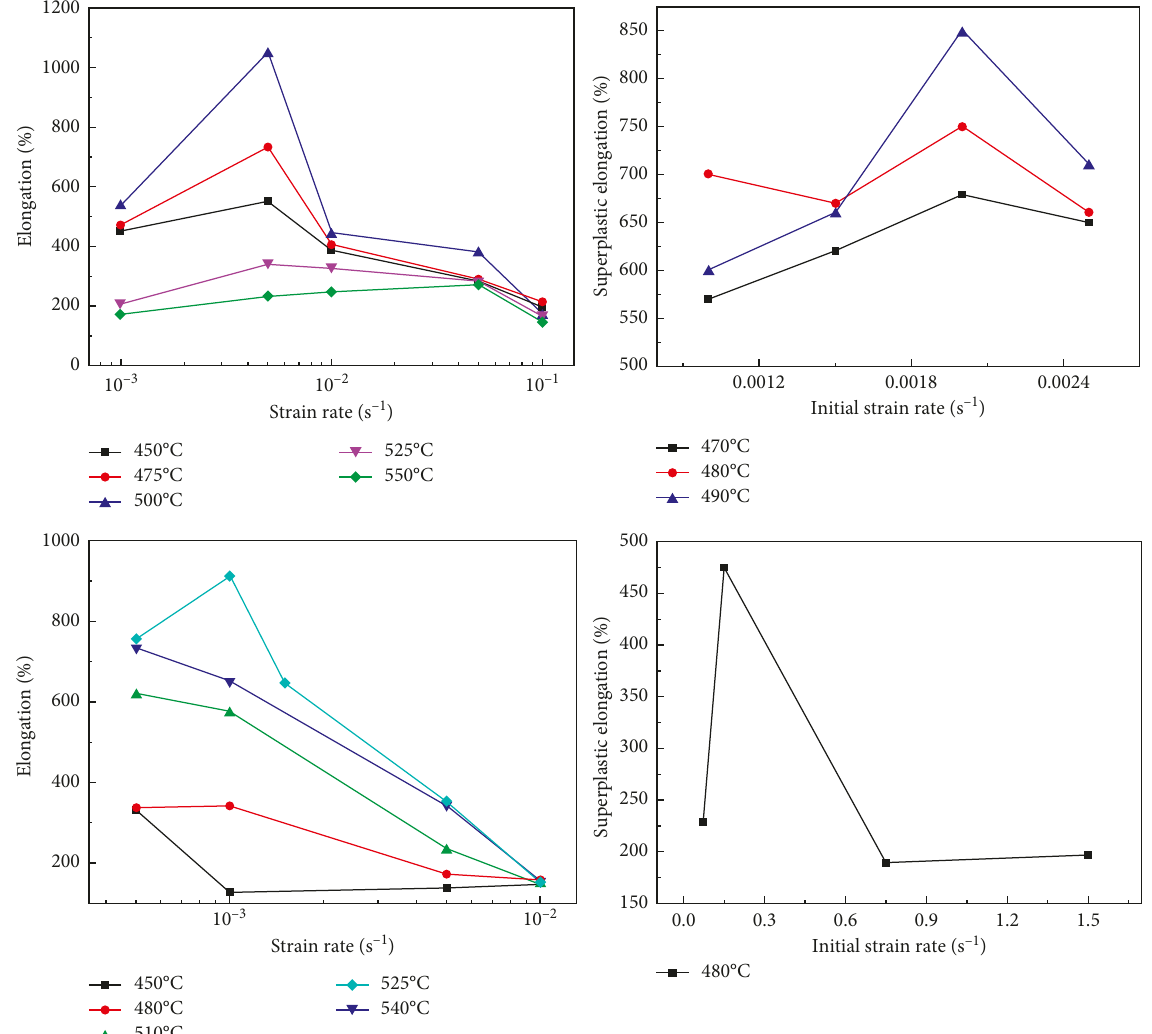
Figure 6: Variation of superplastic elongations of different Al alloys with varying initial strain rates at various temperatures. (a) Al-Zn-Mg- Sc-Zr [56]; (b) Al-Li-Cu; (c) Al-Mg-Si [47]; (d) 5wt.%Al 3